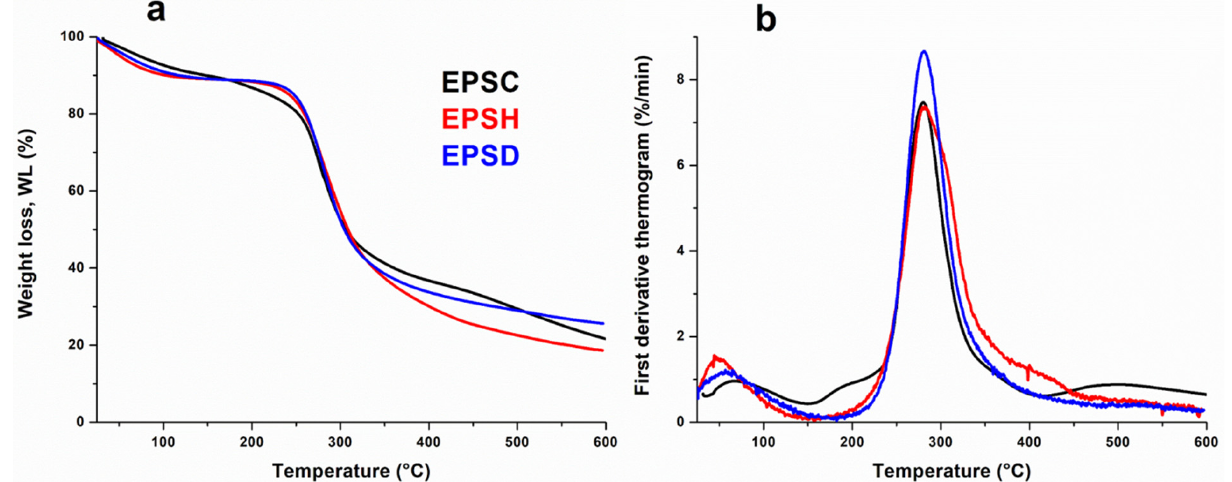
Figure 5. EPS-based sample thermograms: Weight loss (%) (TGA) ( a ) and thermal degradation rate (DTG) ( b ).